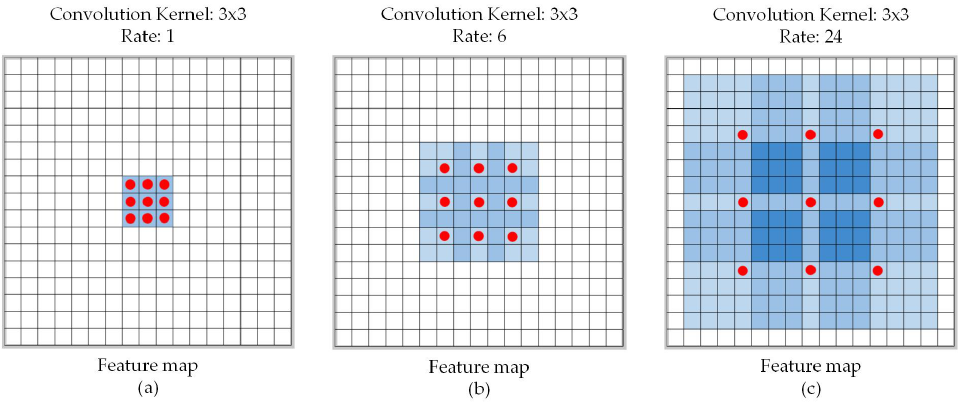
Figure 3. Examples of atrous convolution